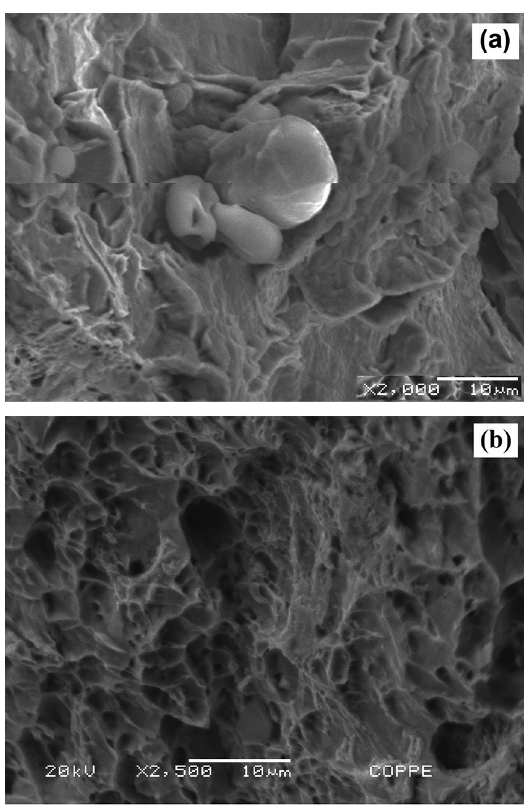
Figure 10: SEM of fracture surface after Charpy tests of the hydrogenated specimens of the fusion zone region: (a) rough aspects and microvoids; (b) quasi-cleavage